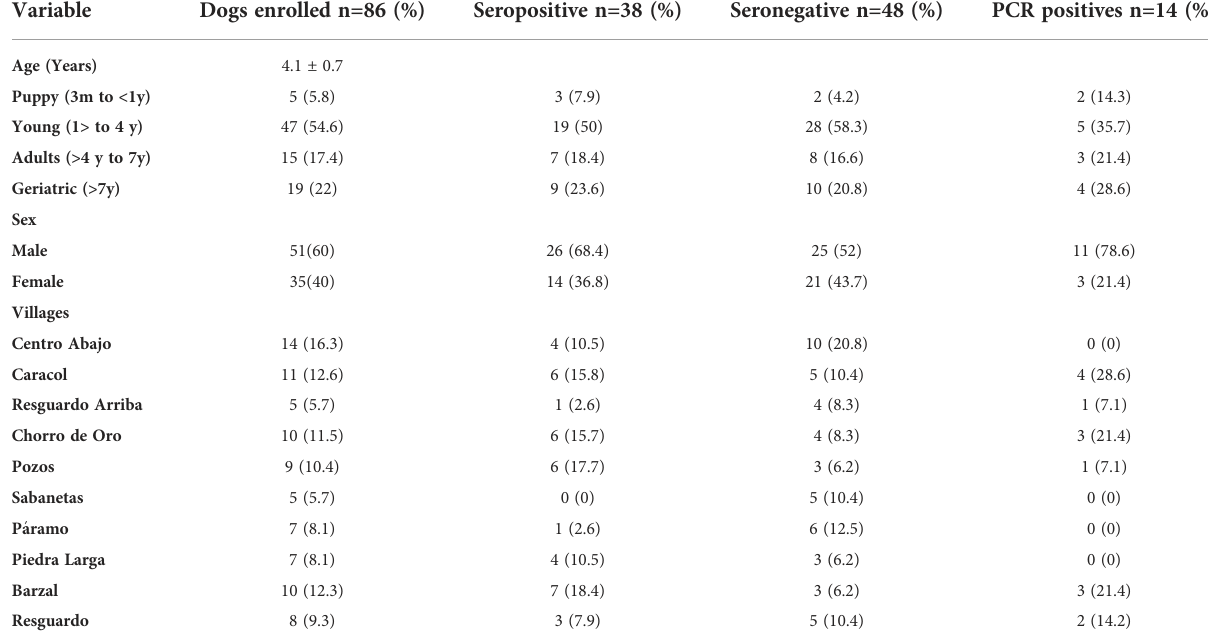
TABLE 3 T. cruzi infection and serological data of dogs per age, sex and village. Variable